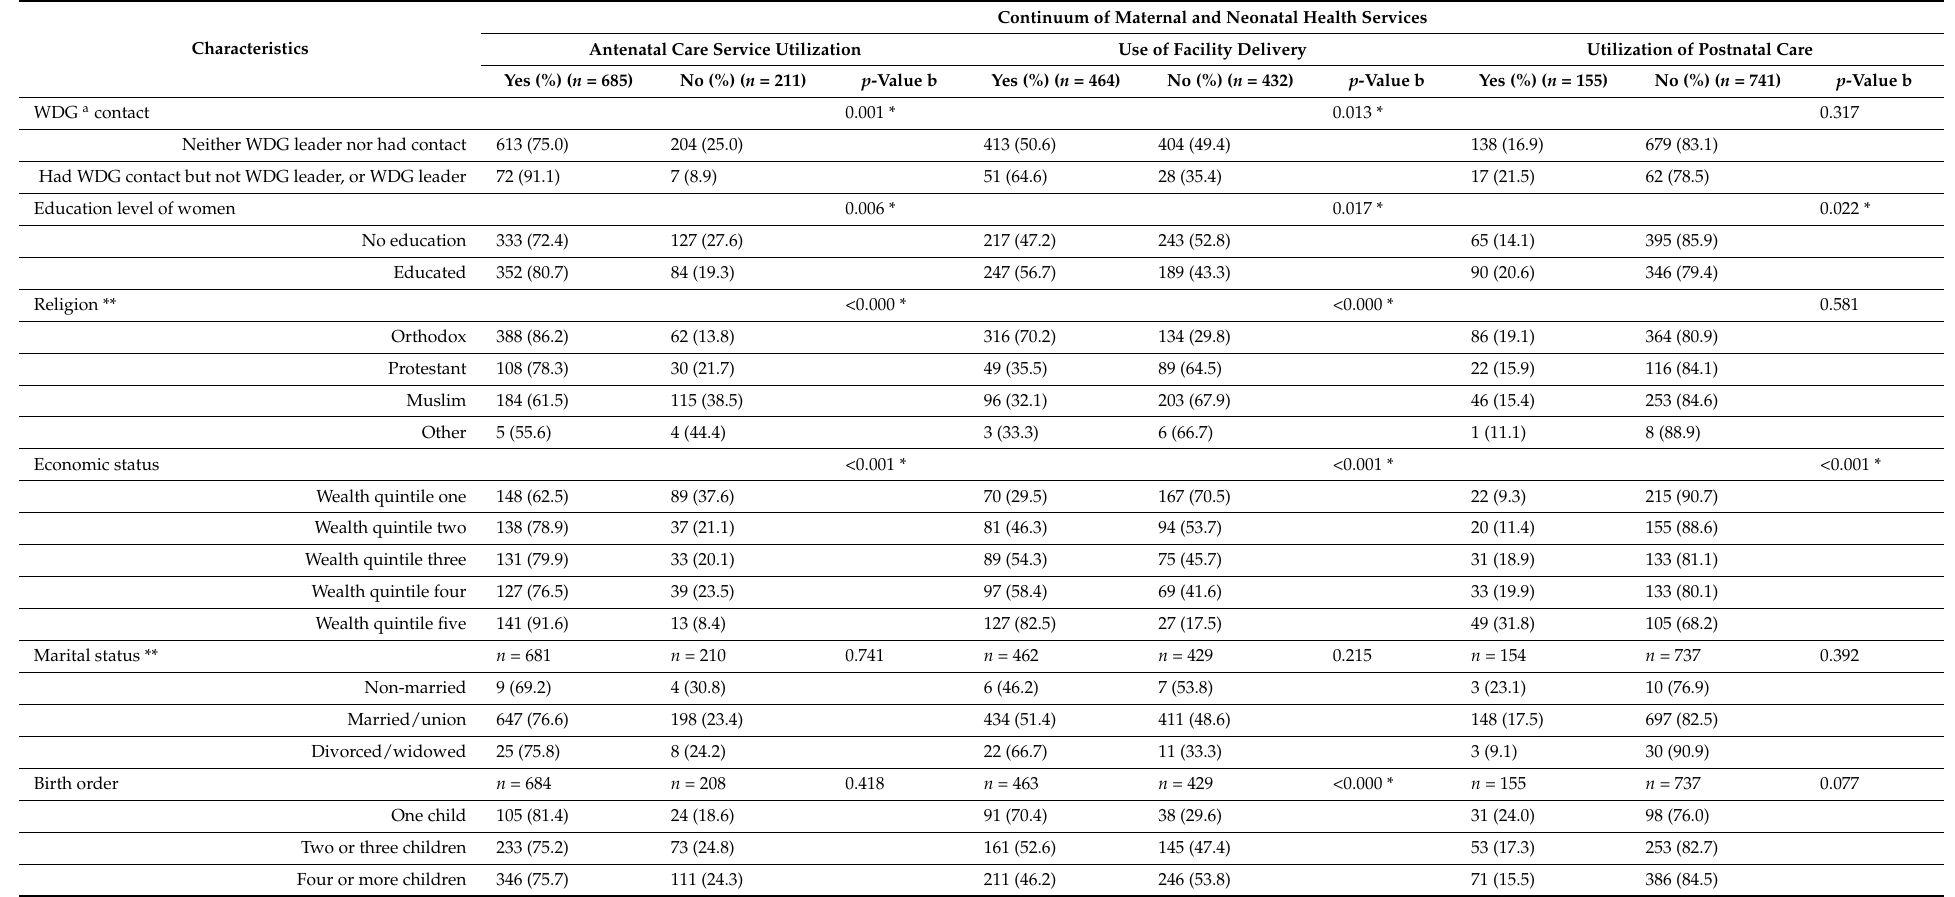
Table 2. WDG contact and distribution of socio-economic characteristics of women across utilization of maternal and neonatal health services in Ethiopia, 2018/19.